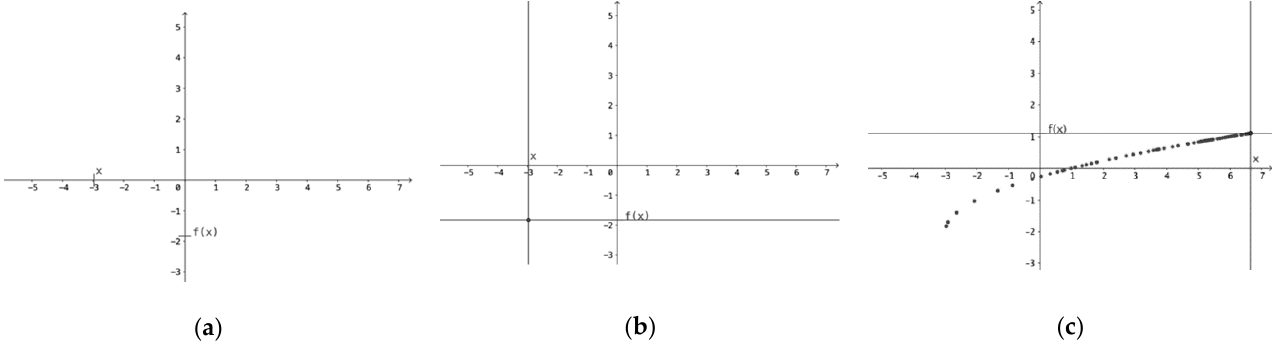
Figure 1. The process of construction of an SGc from a DGc in the DIE. ( a ) Two ticks representing x and 𝑓(𝑥) are respectively on the x -axis and on the y -axis. The tick that represents x can be (directly) dragged and the movement of x causes the (indirect) movement of 𝑓(𝑥) , according to the functional dependency. ( b ) The point (𝑥,𝑓(𝑥)) is built as the intersection point of the perpendicular line to the x -axis passing through (𝑥, 0) and the perpendicular line to the y -axis passing through (0, 𝑓(𝑥)) . ( c ) The activation of the trace mark on (𝑥,𝑓(𝑥)) and the dragging of x allow to visualize the trajectory of (𝑥, 𝑓(𝑥)) and then the graph of the function.